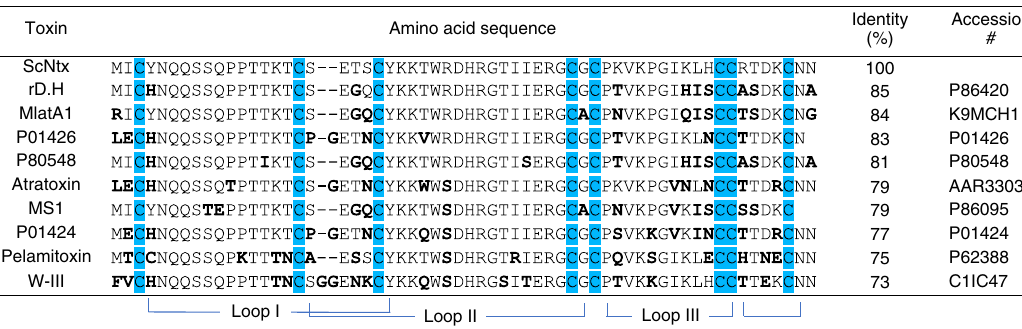
Fig. 3 Multiple sequence alignment of the most lethal short-chain α -neurotoxins. ScNtx: Synthetic consensus α -neurotoxin 10 ; rD.H: Micrurus diastema (recombinant) 53 ; MlatA1: Micrurus laticollaris (recombinant) 52 ; P01426: Naja spp.; P80548 : Micrurus nigrocinctus 4 ; Atratoxin: Naja atra ; MS1: Micrurus surinamensis ; P01424: Naja melanoleuca ; pelamitoxin: Hydrophis platura ; W-III: Walterinnesia aegyptia . Differences from the ScNtx are indicated by